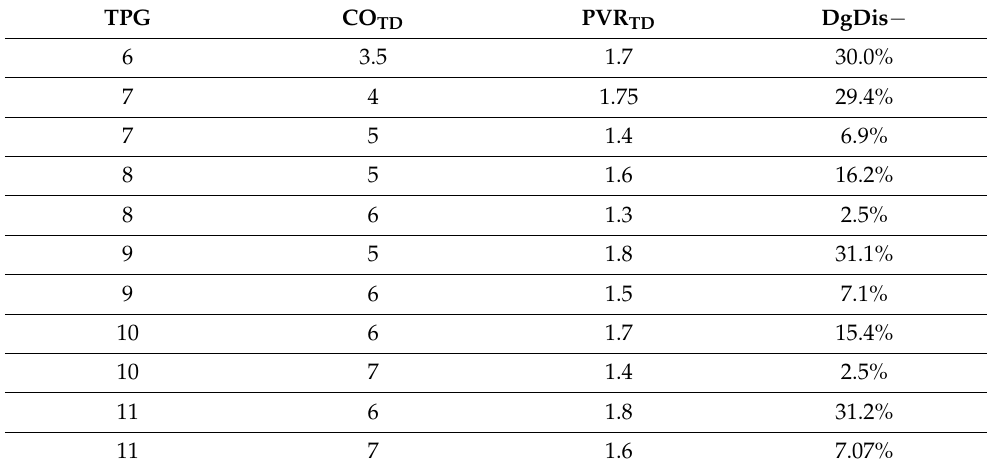
Table 2. Patients diagnosed with «unclassified PH» using TD and corresponding DgDis − probability.